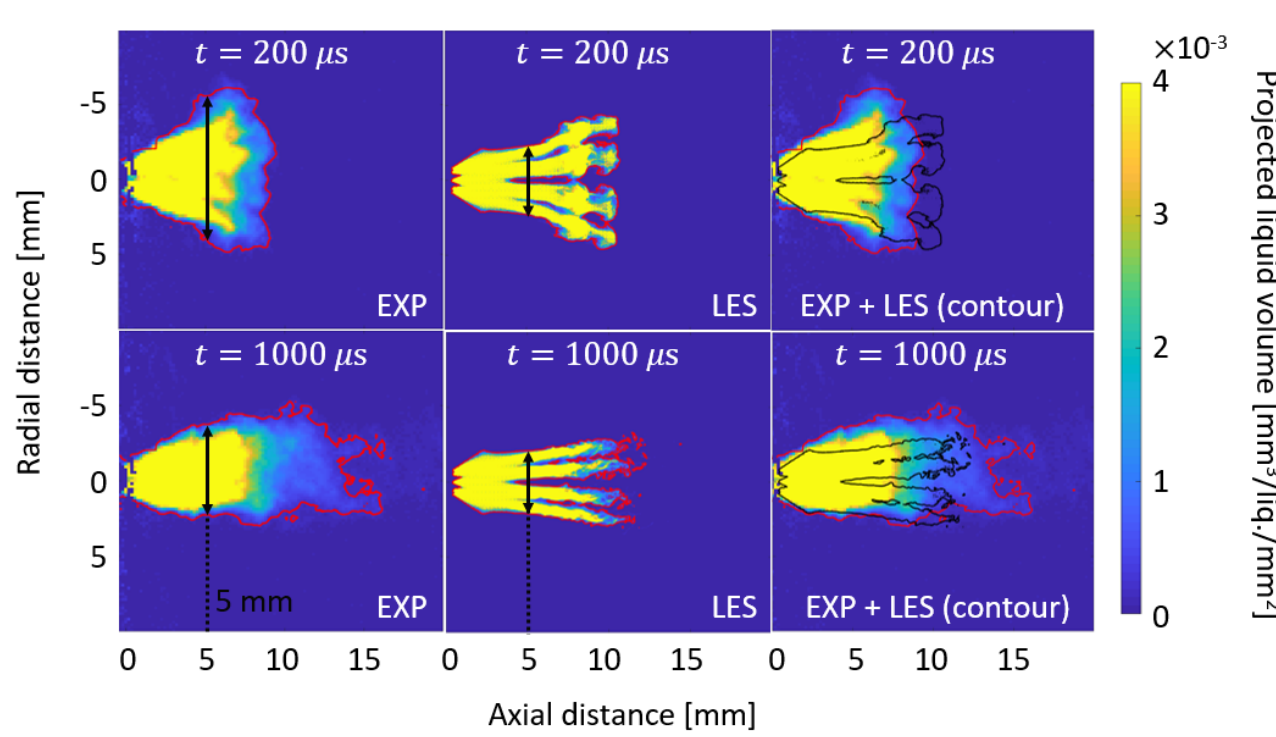
Figure 4. Projected liquid volume comparison between the experiments (EXP) and the simulations (LES) at the beginning of injection and just before the end of injection (injection duration is 1.158 ms). Both EXP and LES images shown are ensemble-averaged. The red and black iso-lines represent PLV = 2 × 10 − 4 mm 3 liq./mm 2